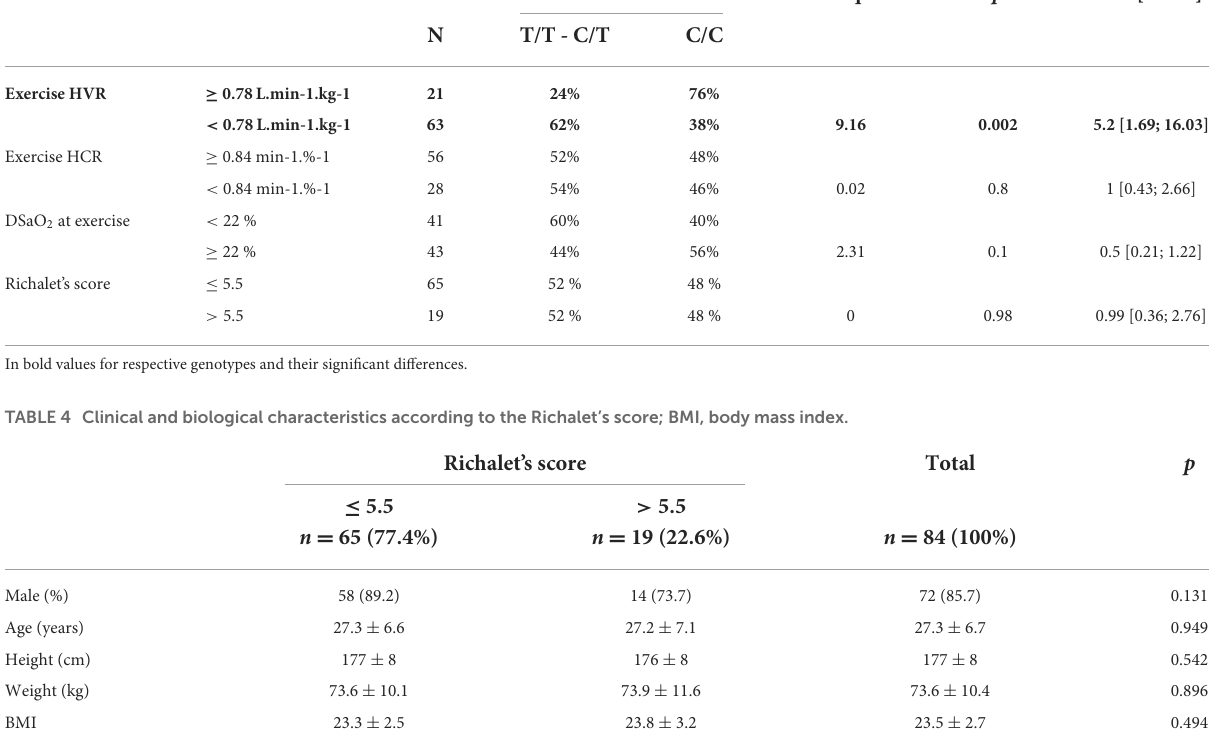
TABLE 3 Contingency table showing the correlation between HMOX2 genotypes and calculated parameters; HVR, hypoxic ventilatory response; HCR, hypoxic cardiac response; DSaO 2 , difference on saturation. HMOX2 Chi-square p OR [IC 95] N